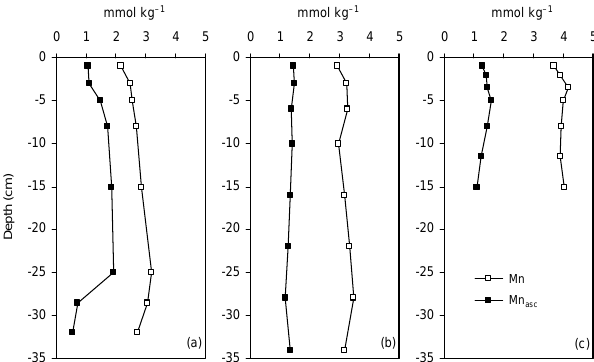
Fig. 4. Concentration-depth profiles of total Fe and ascorbate- extractable Fe (Fe asc ) in the sediments of (a) Lake Shirokoe (3rd stage), (b) Lake Yamsovey (4th stage), and (c) Lake Khasyrei (5th stage). Figure 4 Audry et al.